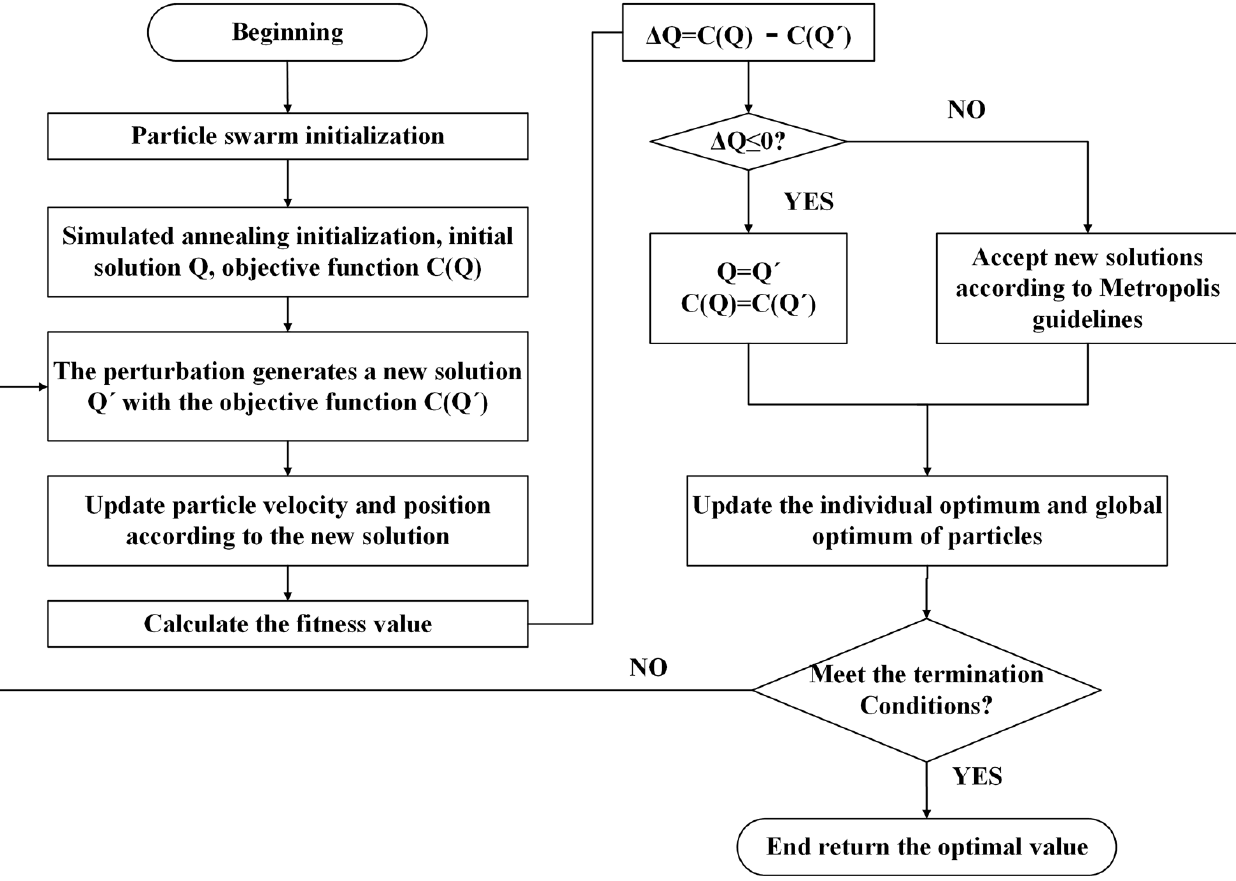
Figure 2. SAPSO algorithm flow chart.